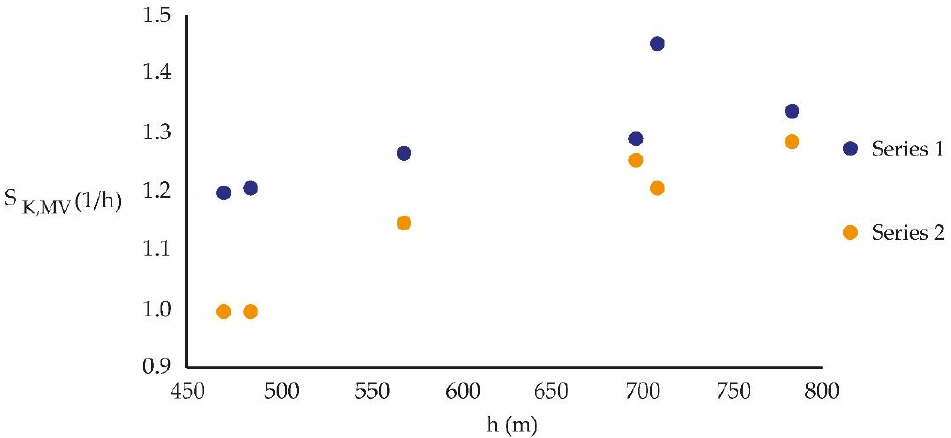
Figure 3. Distribution of entropies according to heights and periods of the meteorological variables.